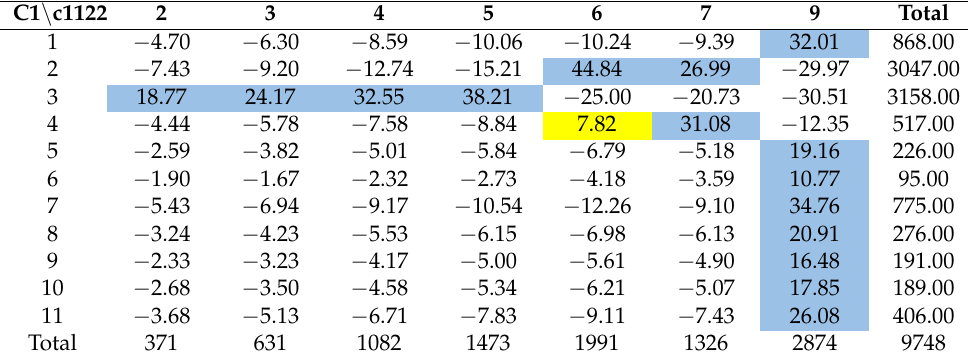
Table A3. Theoretical frequencies DRF 2018 (C1 \ c1122).